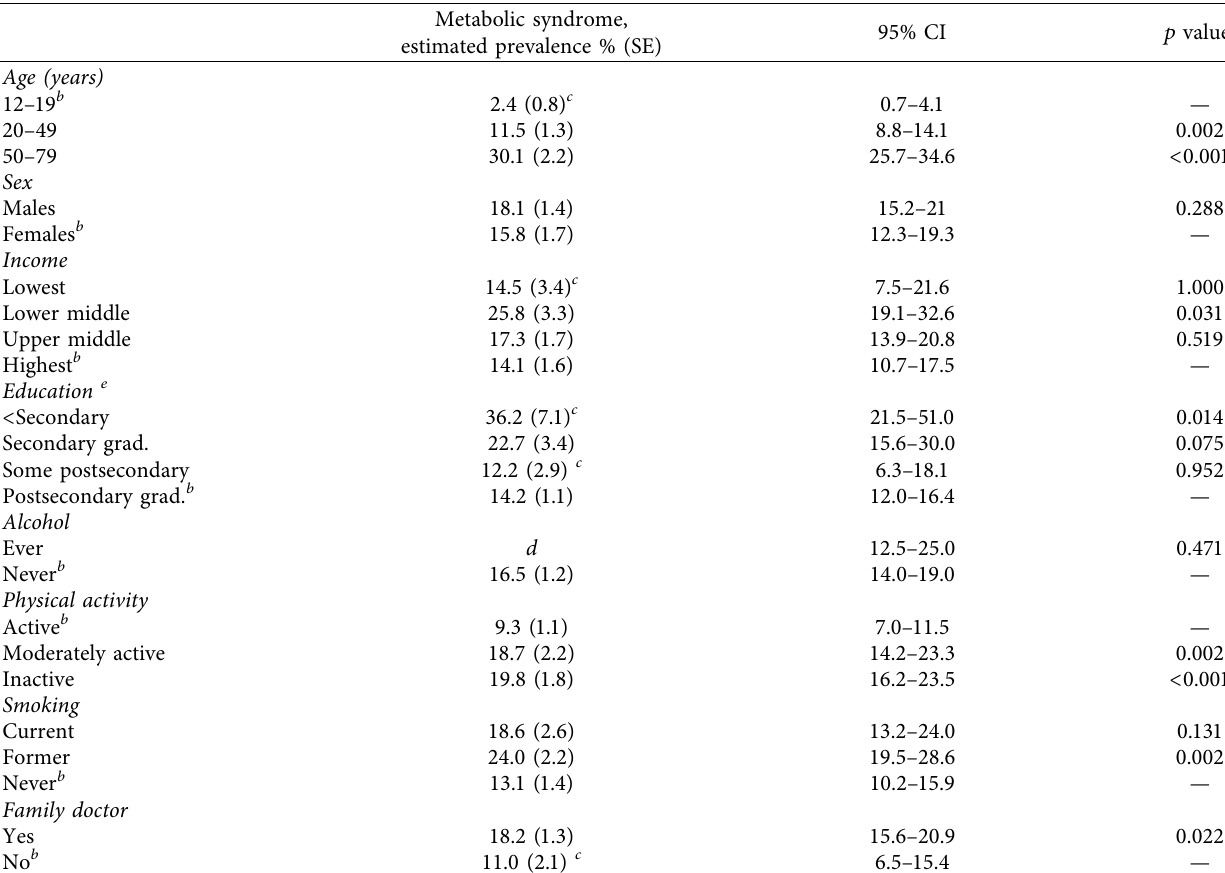
Table 1: Prevalence (weighted estimate) of metabolic syndrome across sociodemographic and lifestyle factors of Canadians aged 12 to 79 years, Canadian Health Measures Survey combined Cycles 1 and 2,